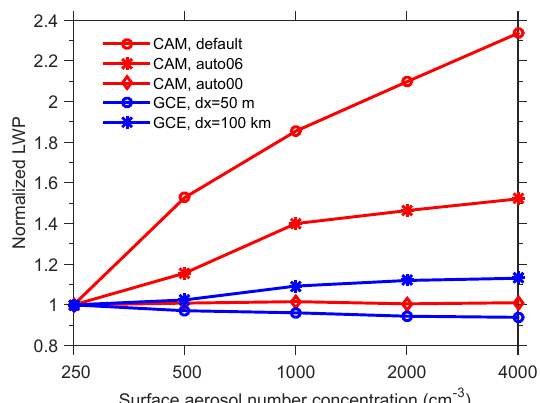
Figure 4. Normalized LWP as a function of surface aerosol concen- tration from CAM (red curves) and GCE (blue curves). A case for CAM using an autoconversion rate proportional to N − 0 . 6 auto06) as well as a case in which autoconversion is independent of N d (CAM, auto00) is shown. The GCE model was run with a horizontal grid resolution of 50m (default case) and